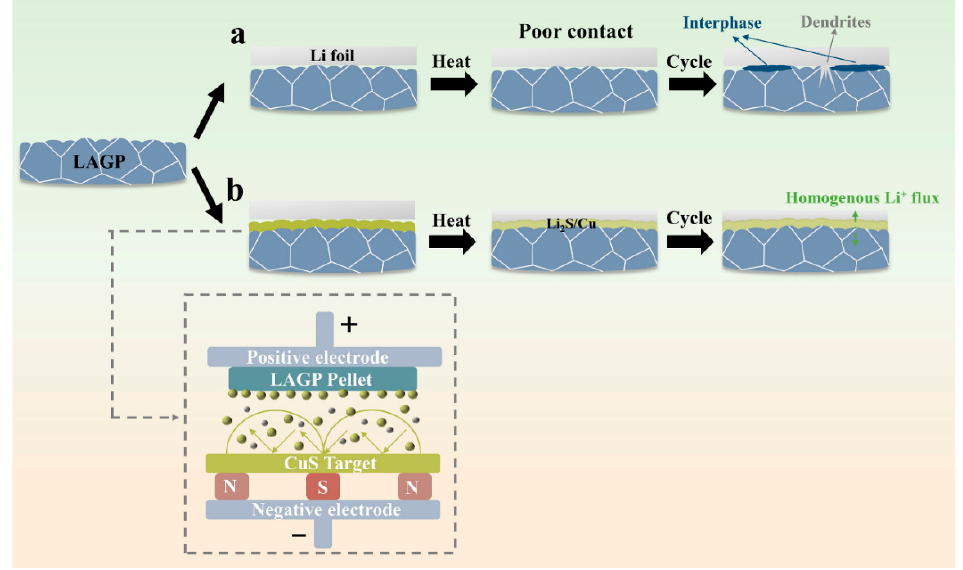
Figure 1. Schematics of symmetric cells’ structure with the Li anode and ( a ) LAGP ( b ) Li 2 S/Cu-modified LAGP as the electrolyte.